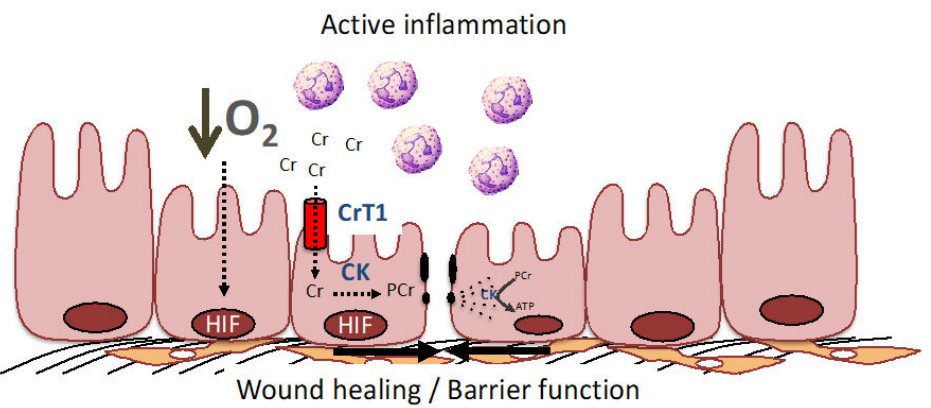
Figure 2. The PCr/Cr shuttle promotes mucosal barrier and wound healing by improving cellular energetics and by stabilization of the adherence junctions. During active inflammation, such as that seen in IBD, low O 2 levels result in the stabilization of HIF and resultant induction of creatine kinase (CK) isoenzymes and the Cr transporter (CrT1) within intestinal epithelial cells (see [16,62,63] for further details). CK localizes to epithelial junctions that are stabilized by interactions with the actin cytoskeleton. In response to epithelial disruption during inflammation, large amounts of ATP are necessary to accommodate the demand for cytoskeletal reorganization, including the acto-myosin ATPase at epithelial cellular junctions. Under such conditions, CK and CrT1 coordinately promote wound healing and barrier function by generating ATP from PCr to efficiently promote